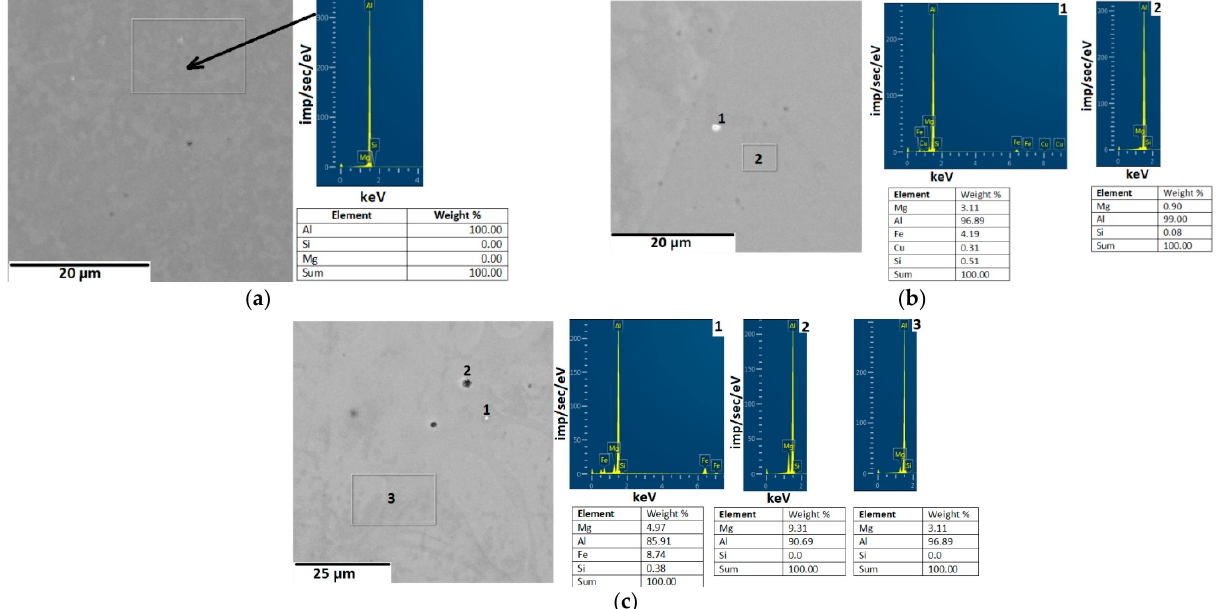
Figure 3. Electron microscopy results for the following alloys: ( a ) Al-95; ( b ) Al-Mg1; ( c ) Al-Mg4. Electron microscopy results demonstrated a negligible amount of intermetallic parti-